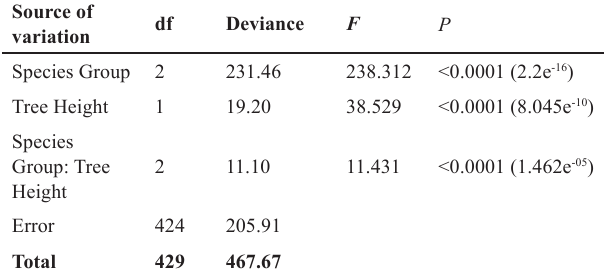
Table 5. Effect of height of the plant species on the intensity of attack by termites in the Cerrado of the Estação Ecológica de Pirapitinga - Minas Gerais. The adjusted minimum model was: ia~species_group+tree_height+species_group:tree_height where species group contains three groups of species that responded differently in the presented intensity of attack: group 1 ( Annona sp . , Pterodon emarginatus , Qualea grandiflora and Qualea multiflora